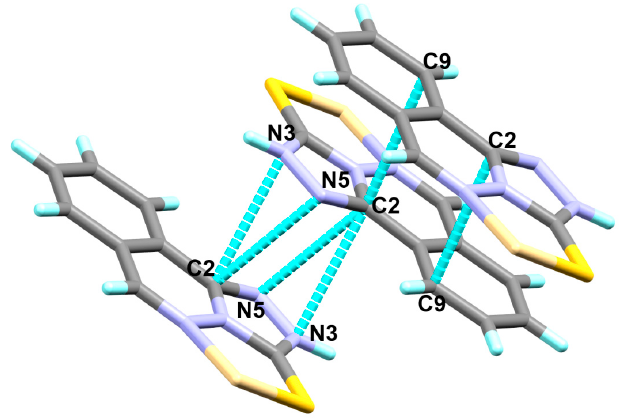
Figure 8. The most important π - π stacking interactions among the stacked organic ligand units in 2.